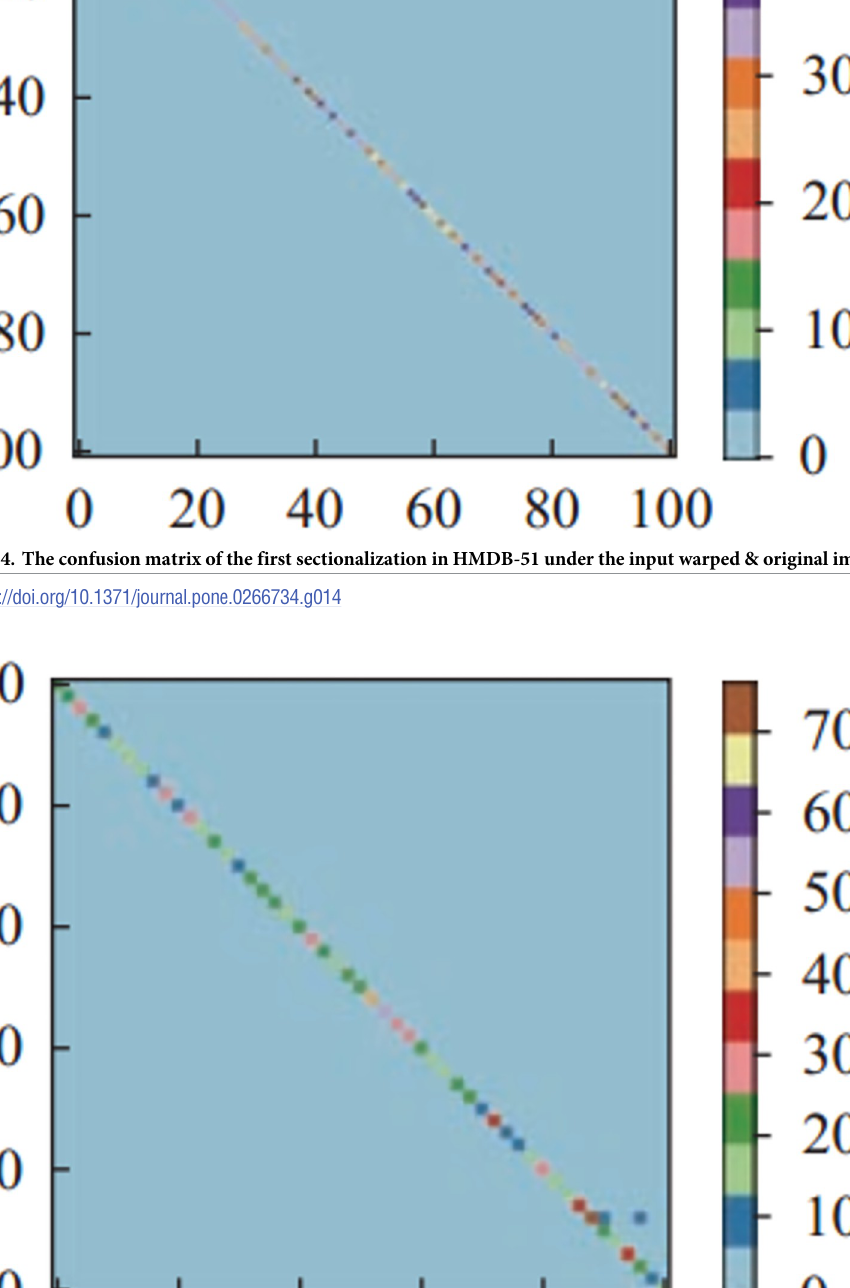
PLOS ONE | https://doi.org/10.1371/journal.pone.0266734 August 1,